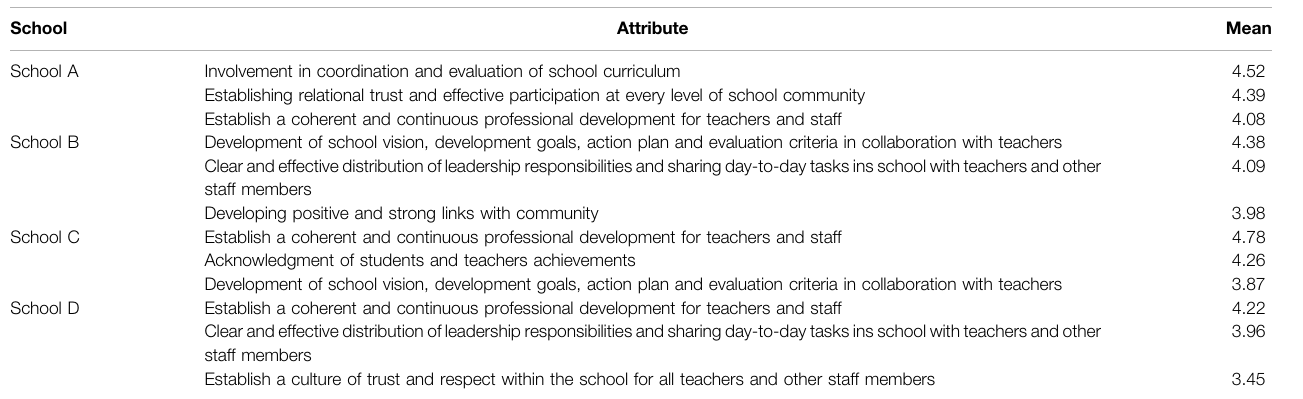
TABLE 4 | Most Prominent Leadership